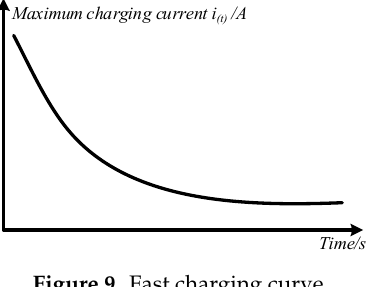
Figure 9. Fast charging curve.